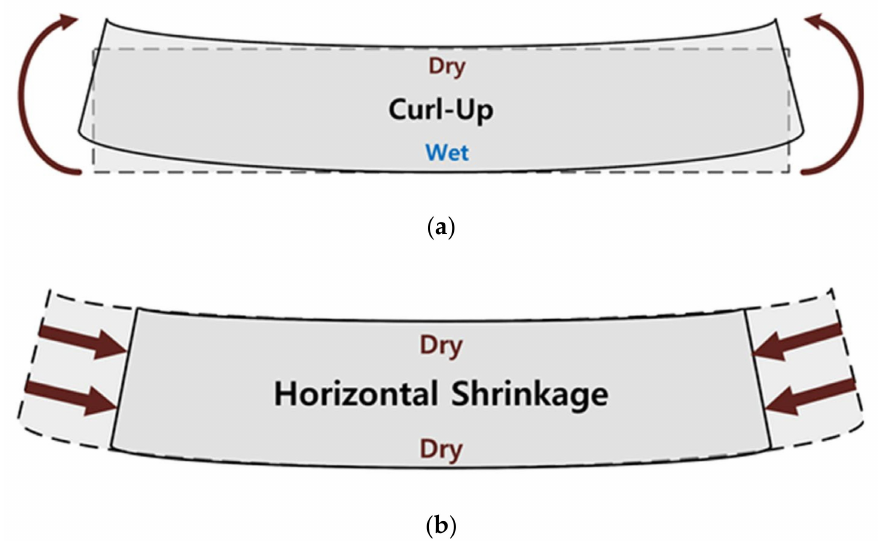
Figure 19. Long-term behavior of concrete slab estimated from the shrinkage strain: ( a ) for the first month and ( b ) after the first